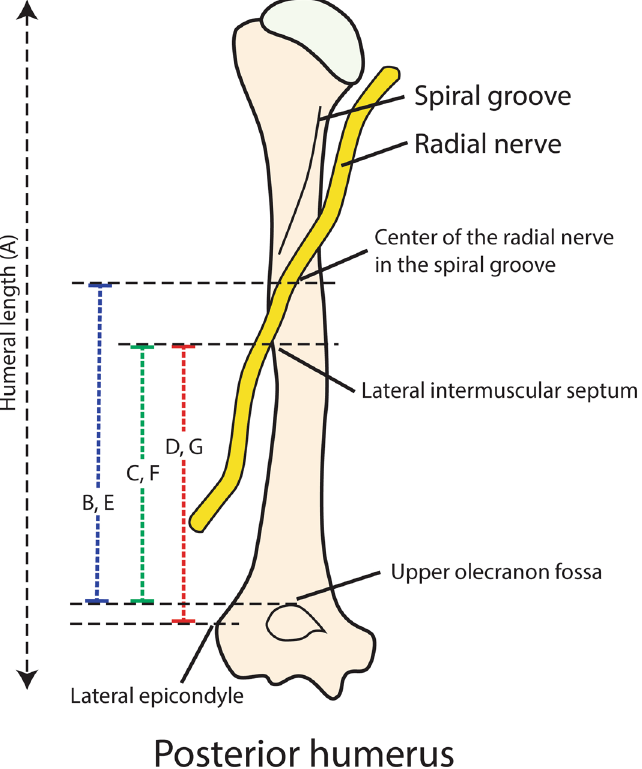
Figure 3. Illustration of the text references for each distance. A: Humerus length: posterior acromion to the tip of the olecranon. B: Upper olecranon fossa to the radial groove in the prone position. C: Upper olecranon fossa to the lateral intermuscular septum in the prone position. D: Lateral epicondyle to the lateral intermuscular septum in the prone position. E: Upper olecranon fossa to the radial groove in the lateral decubitus position. F: Upper olecranon fossa to the lateral intermuscular septum in the lateral decubitus position. G: Lateral epicondyle to the lateral intermuscular septum in the lateral decubitus